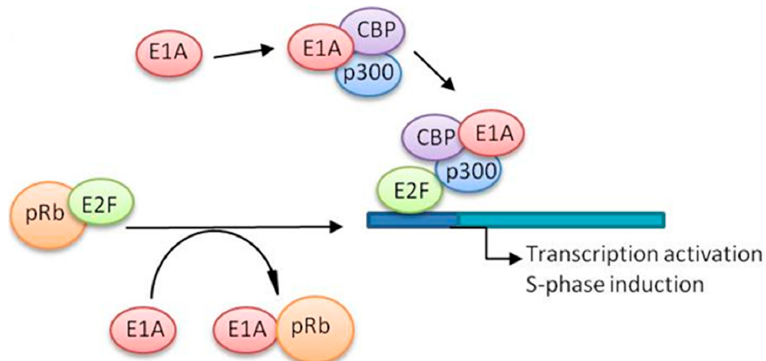
Figure 2. Schematic representation of E1A-mediated regulation of the cell cycle. The E1A adenoviral protein promotes S-phase induction by interacting with pRB and p300.